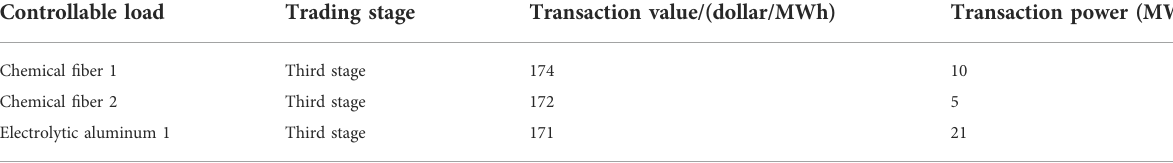
TABLE 6 Third round bidding results of controllable load